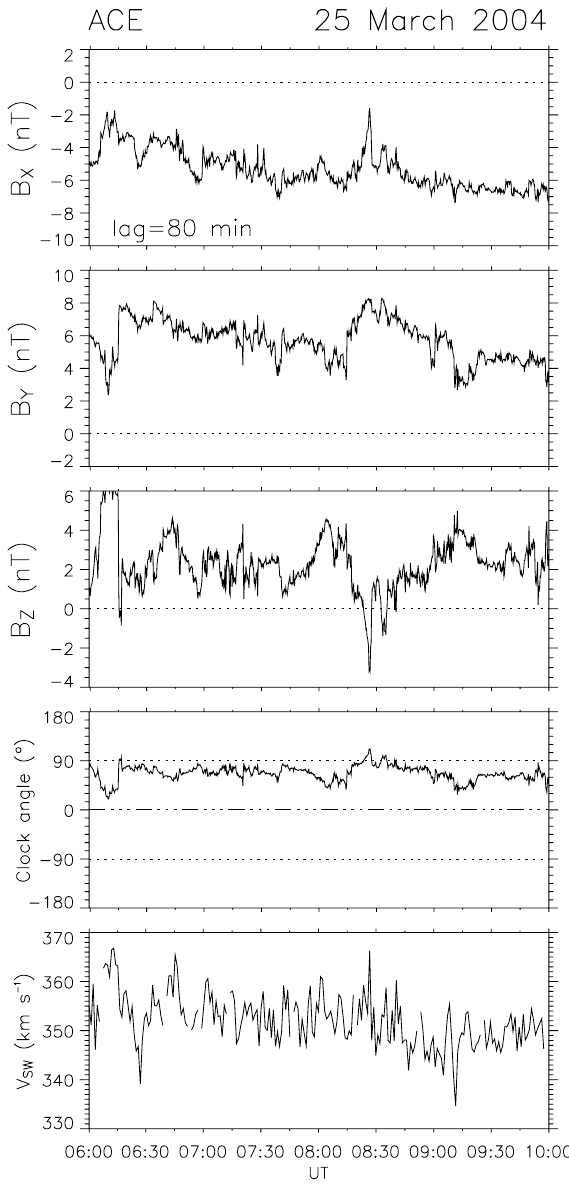
Fig. 3. Solar wind and IMF measurements from the ACE space- craft between 06:00–10:00 UT (lagged time). From top-to-bottom, the panels present the GSM B X , B Y and B Z components of the interplanetary magnetic field, the IMF clock angle (defined as arctan( B Y /B Z )) and the solar wind bulk speed.